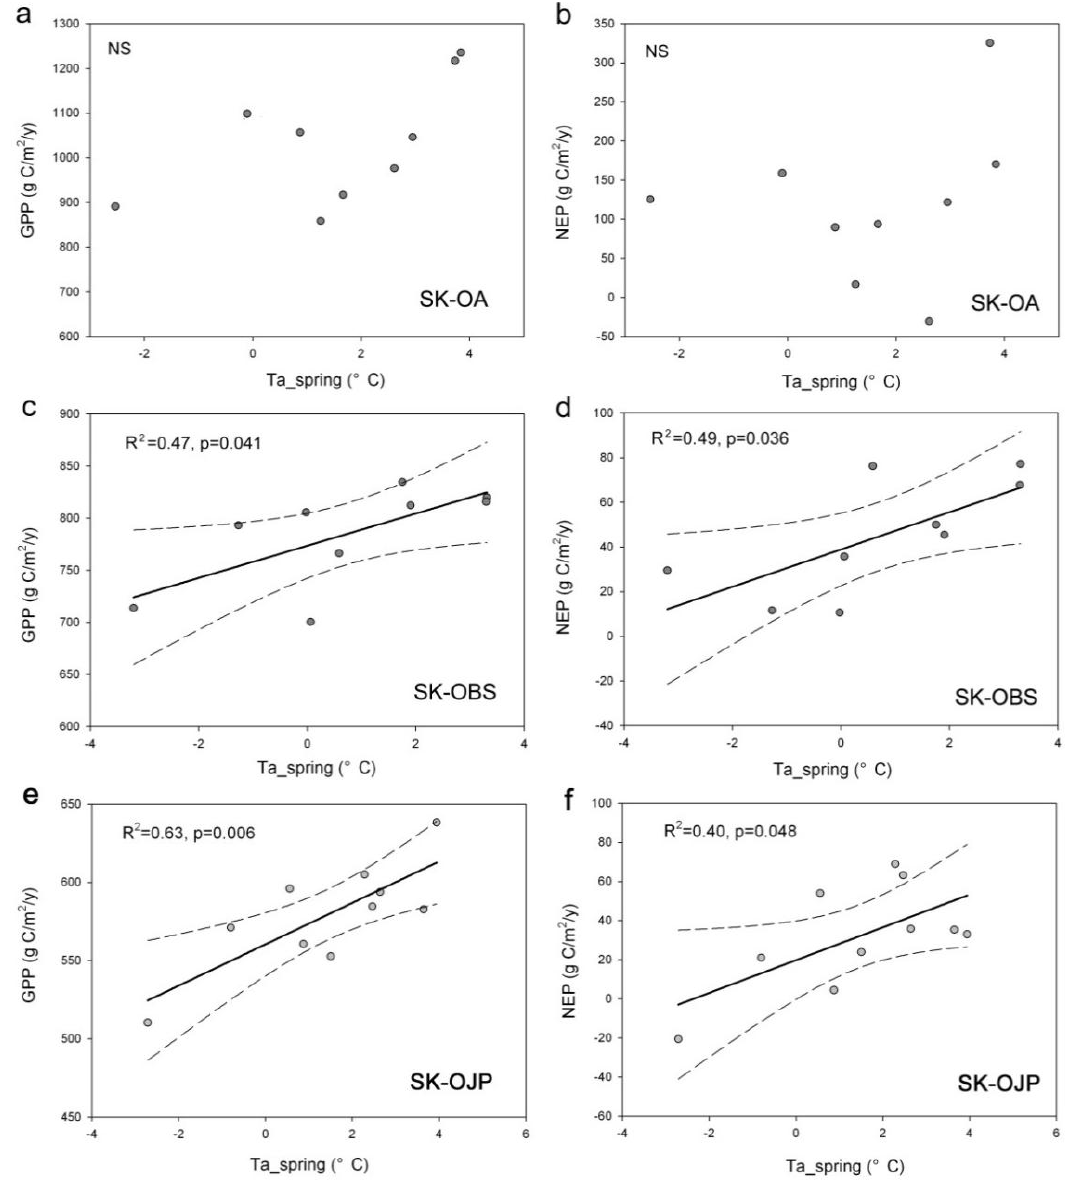
Figure 5. Relationships between spring temperature and ( a ) GPP of SK-OA, ( b ) NEP of SK-OA, ( c ) GPP of SK-OBS, ( d ) NEP of SK-OBS, ( e ) GPP of SK-OJP, and ( f ) NEP of SK-OJP. NS indicates no significant correlation. The solid and dashed lines represent regression and its 95% confidence of mean